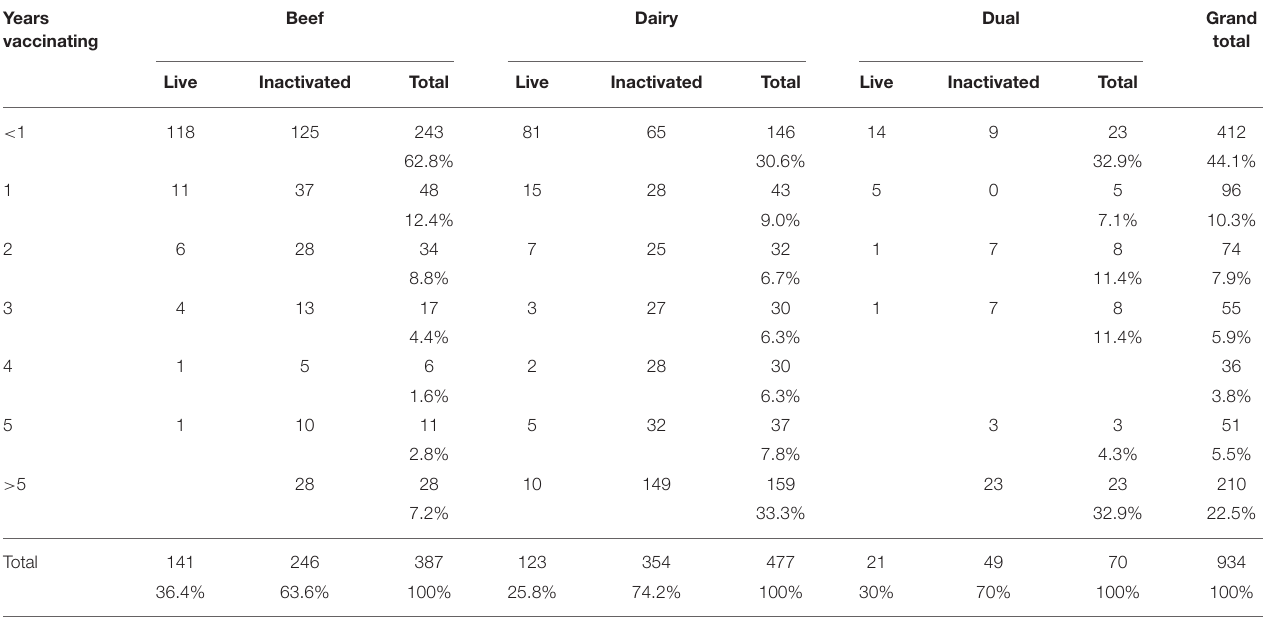
TABLE 7 | BVD vaccination by herd type, number of years vaccinating, and type of vaccine used. Years vaccinating